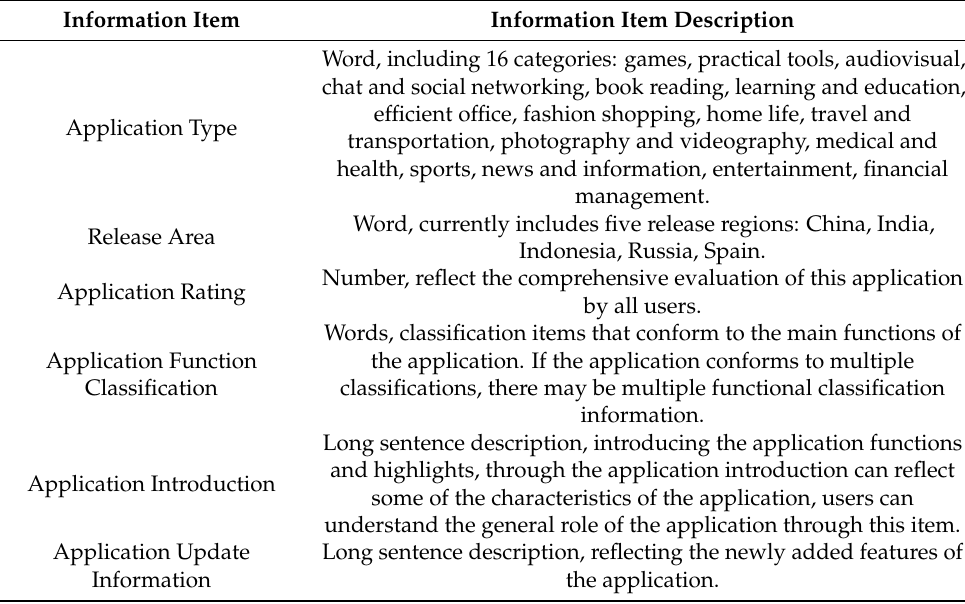
Table 1. Mobile application characteristic information description